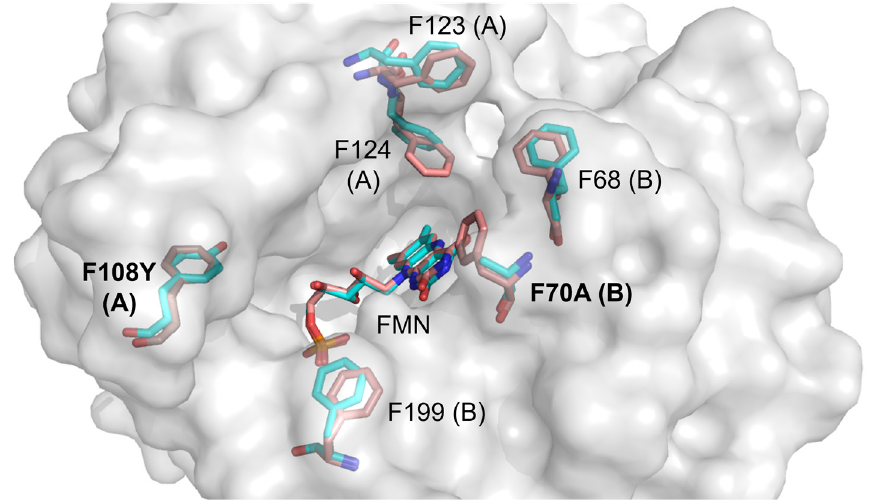
Figure 4. Active site overlay of NTR 2.0 and the parental enzyme. The surface represents the NTR 2.0 structure. Wild-type (red) and NTR 2.0 mutant (cyan) residues exhibiting significant differences and FMN molecules are shown as sticks . Chain identity (A or B) is identified in parentheses after each numbered residue.